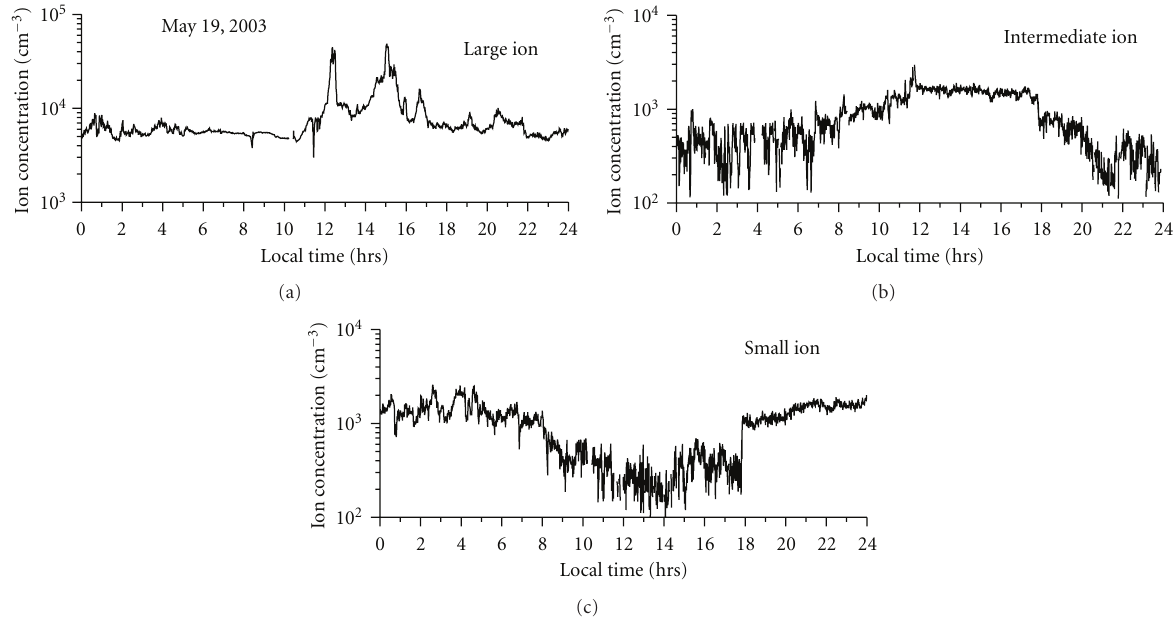
Figure 5: Diurnal variation of small, intermediate, and large ions on a fair weather day (May 19, 2003) observed during cruise period. reports of diurnal variation of atmospheric ions over